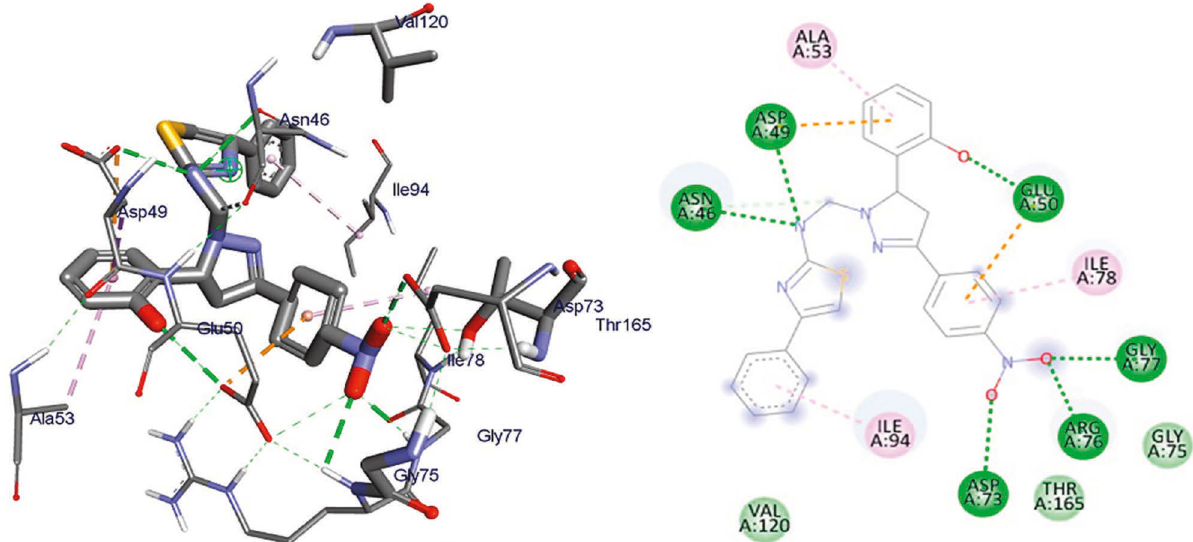
Figure 5: 3D (a) and 2D (b) representations of the binding interactions of 22 against E. coli DNA gyrase B.